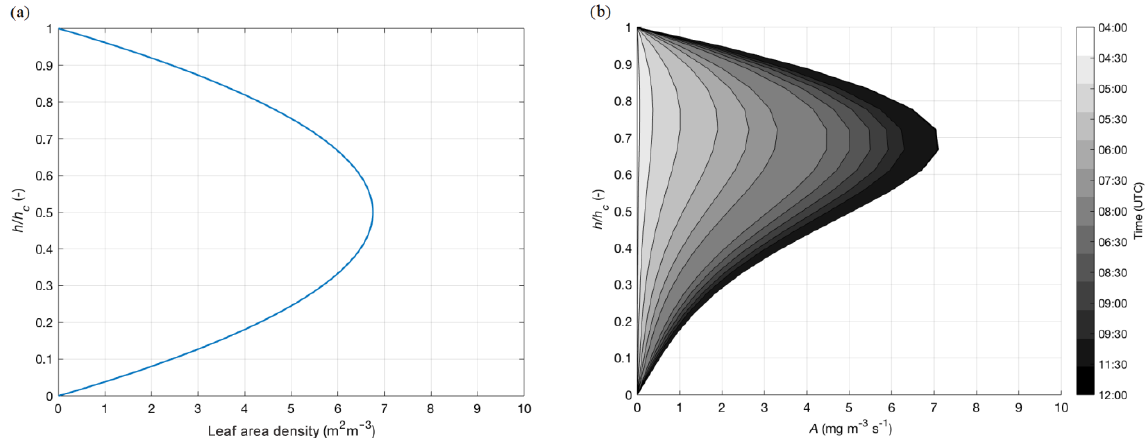
Figure 8. (a) Leaf area density (m 2 m − 3 ) on 7 May 2018 as a function of height ( h ) normalized to the maximum canopy h ( h c ). The leaf profile is typical for winter wheat, as defined by Olesen et al. (2004). (b) Time evolution of CO 2 gross primary production A (mgm − 3 s − 1 ) on 7 May 2018 as function of h normalized to h c . The profile is obtained using the profile measurements and using Eq. (2).